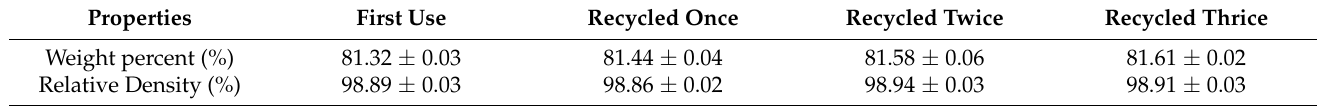
Table 3. Change in properties with recycling.